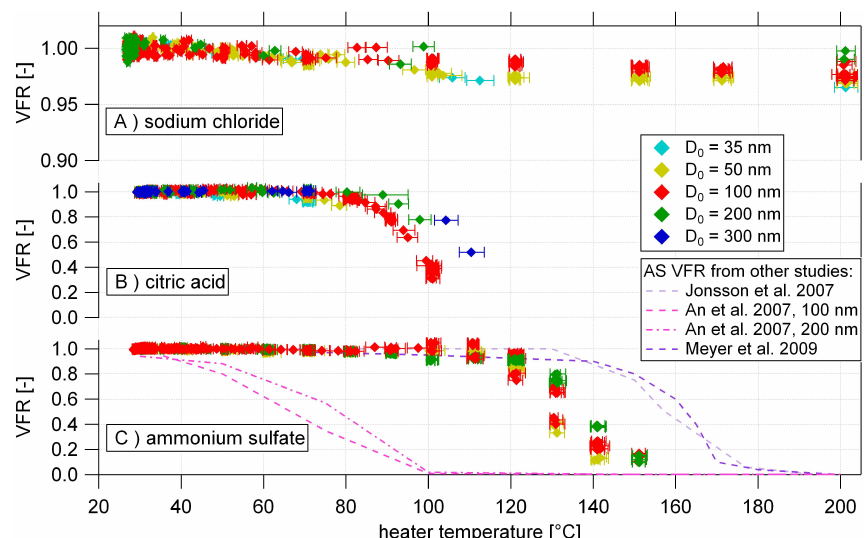
Fig. 3. Thermograms, normalized volume fraction remaining (VFR) plotted against the measured heater temperature, for sodium chloride (NaCl) in panel (a) , citric acid in panel (b) and ammonium sulfate (AS) in panel (c) as retrieved from the V-TDMA measurements. Different dry diameters ( D 0 ) are distinguished by color and the error bars represent the minimal and maximal temperature during a scan. In panel (c) thermograms for AS from other studies were added for comparison (dashed